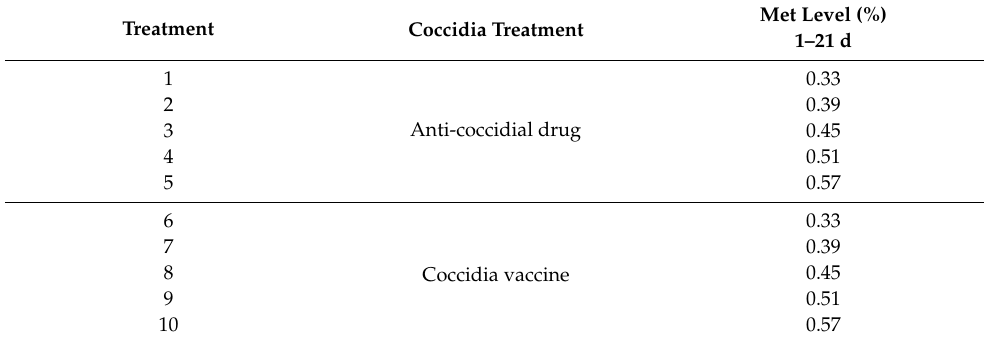
Table 2. Experimental